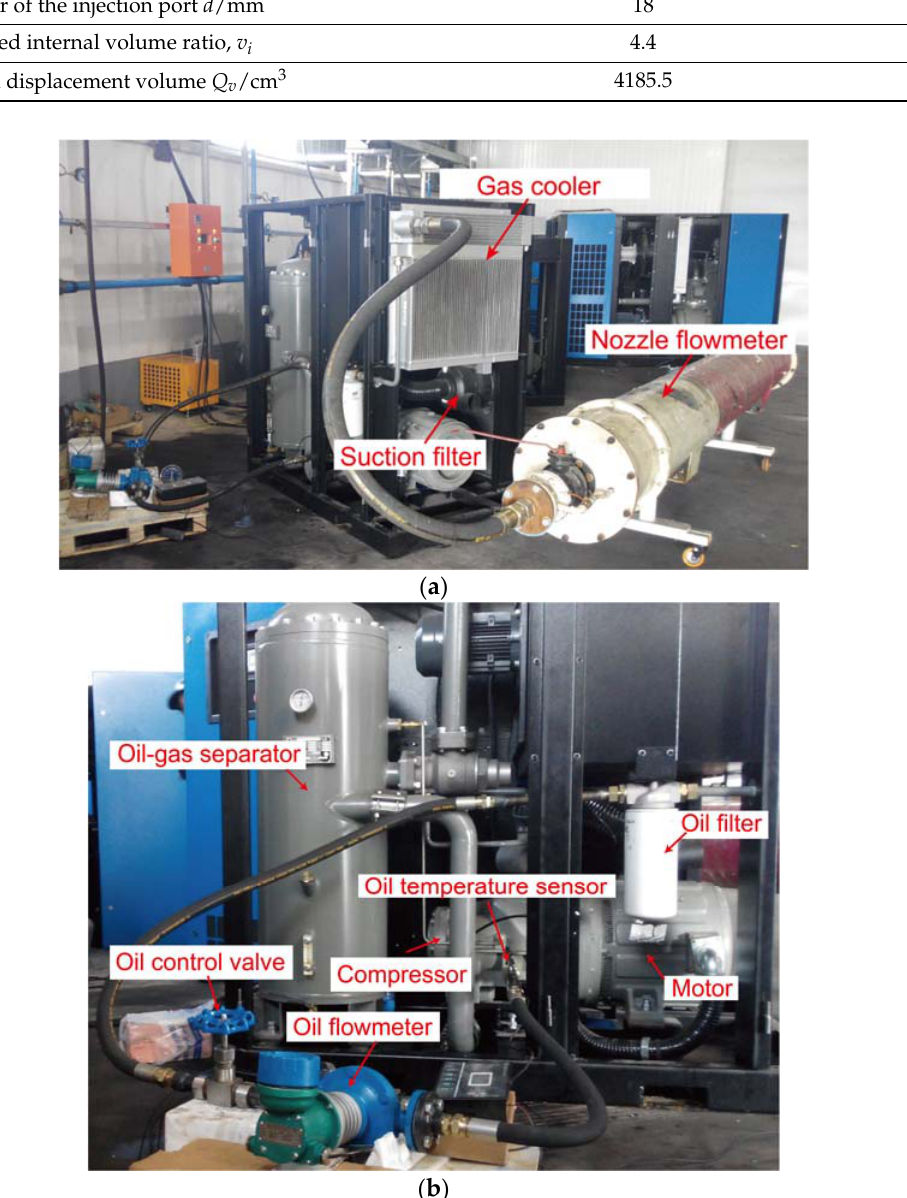
Figure 2. ( a ) Picture of the twin ‐ screw air compressor unit; ( b ) picture of the oil circulation and control loop. Table 1. Main parameters of the TRL135 twin ‐ screw air compressor.